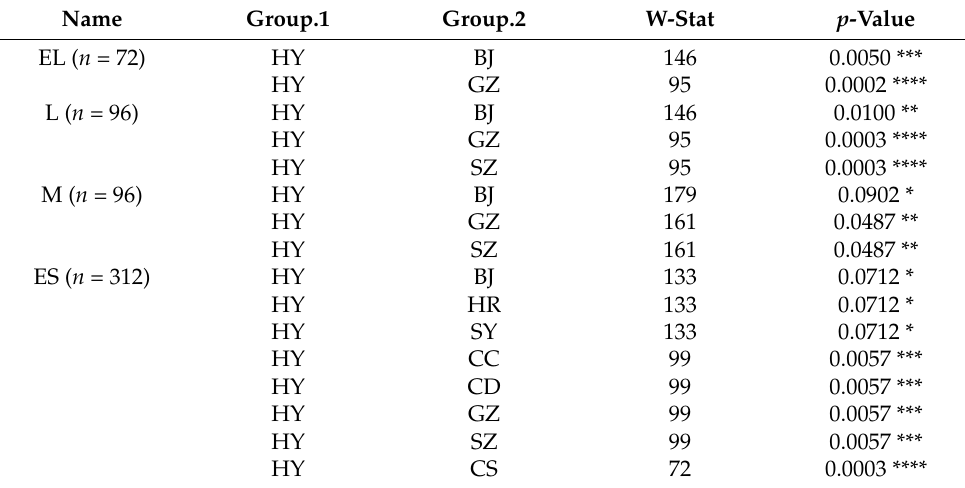
Table 6. The differences between HY and wholesale markets and between the wholesale markets in the HY